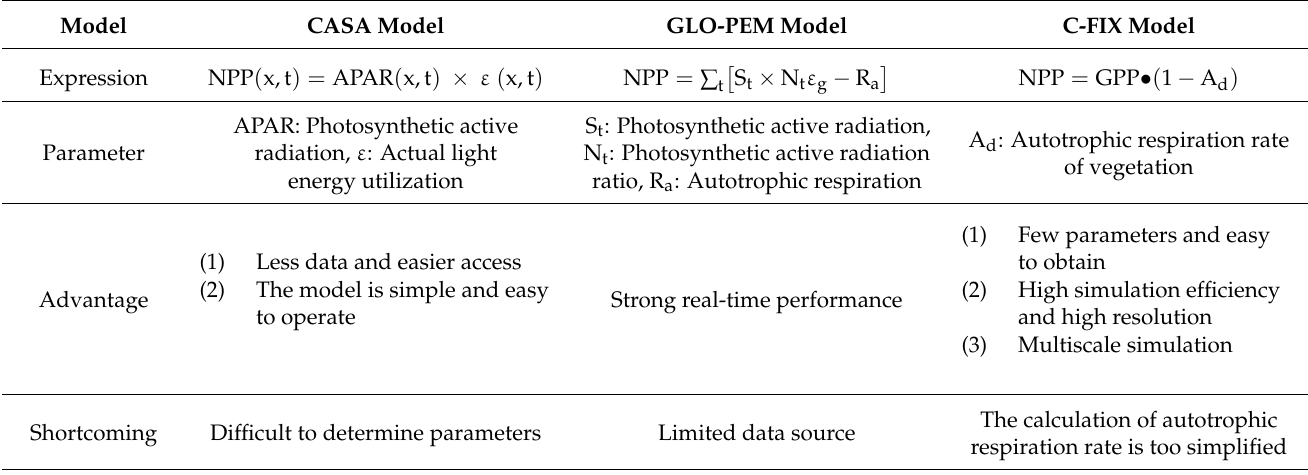
Table 2. Typical light energy utilization models and their advantages and disadvantages